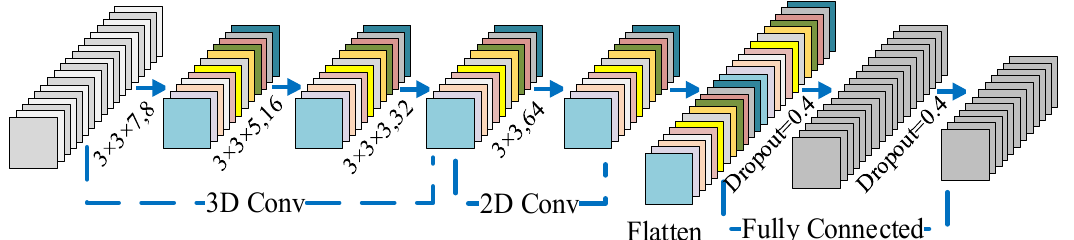
Figure 6. 3-D CNN framework diagram. Each convolutional layer is used with a ReLU function. The stride of each layer is 1.